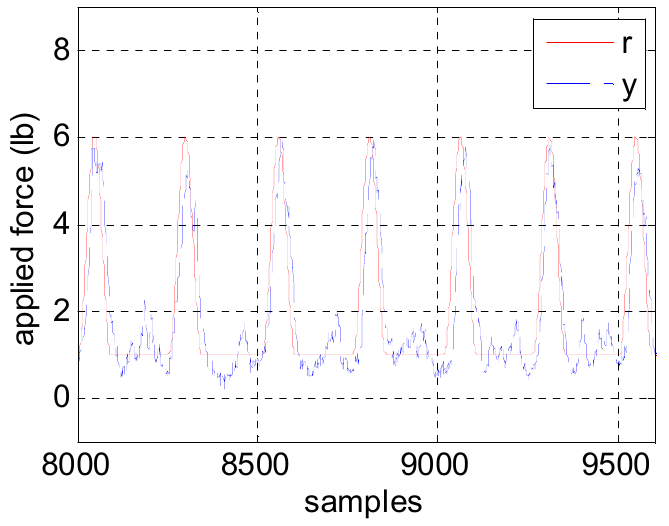
Figure 11. Force responses employing the motor control system.